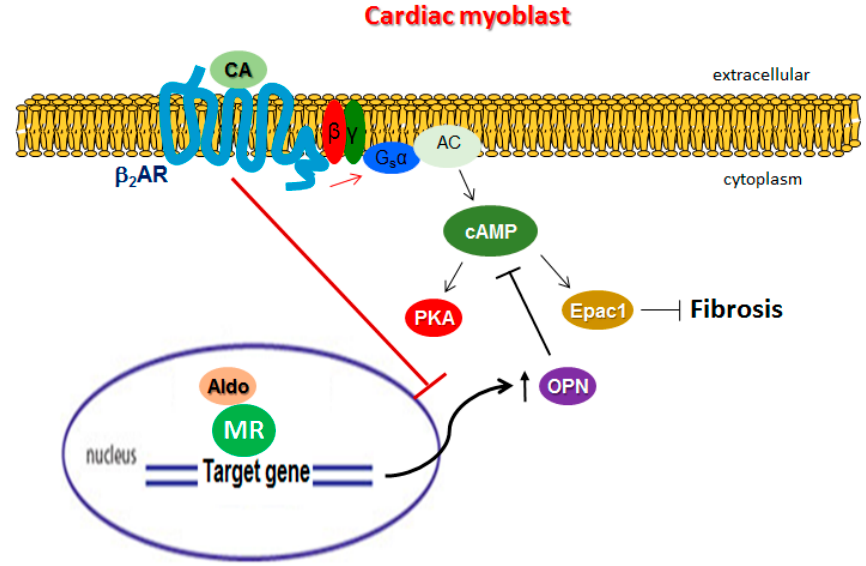
Figure 6. Schematic illustration of the proposed role of OPN in β 2 AR ant-fibrotic signaling in H9c2 cardiomyocytes. CA: catecholamine; MR: mineralocorticoid receptor. See text for details and for all other molecular acronym descriptions.